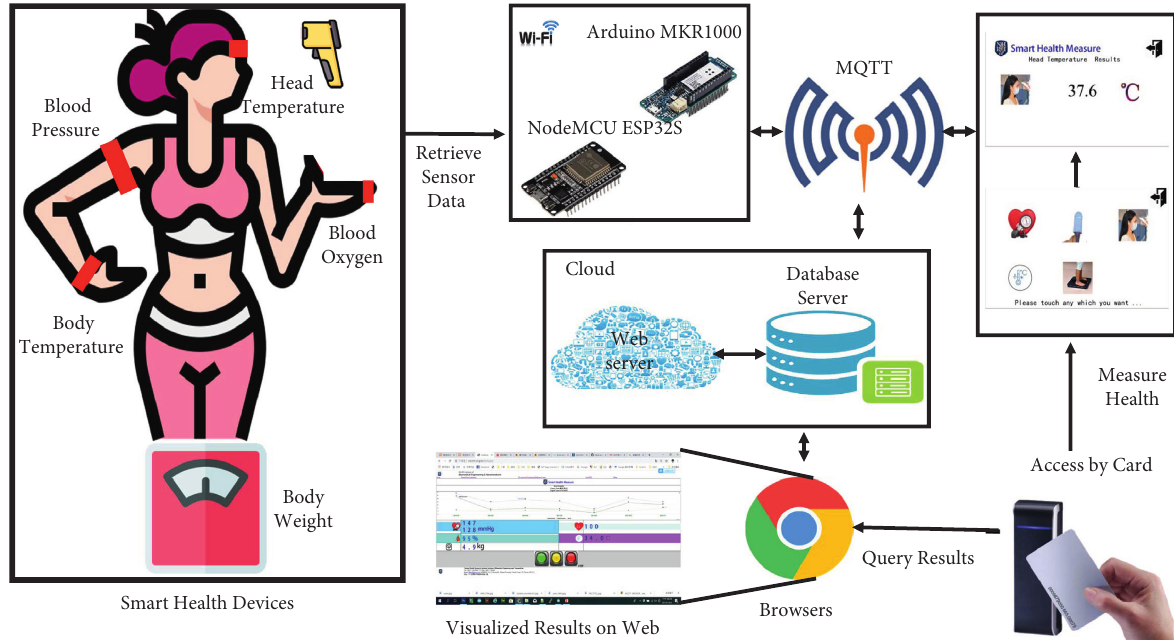
Figure 1: Proposed system architecture, including the layout and system structure, how each device (developed with an MCU, including an ESP32 and an Arduino MKR1000) measures clients’ physiological health parameters and transmits sensor data via an MQTT broker to the cloud platform (which is established in this research), and how all data are stored in a database server that is accessible via a website. Users can instantly obtain any measured result on an RFID device after taking a measurement, including head temperature, body temperature, body weight, blood oxygen level, and blood pressure. In particular, users can obtain integrated online health reports through a browser via a PC, smartphone, etc. Furthermore, all information can be collected and classified into personal health records via health ID cards and synchronously shared with family members and physicians. This proposed system architecture facilitates information sharing (isolated from developers’ technology barriers and gaps) based on pure information flows through an MQTT broker despite using individual information technology (IT) structures designed and developed by each enterprise or organization.